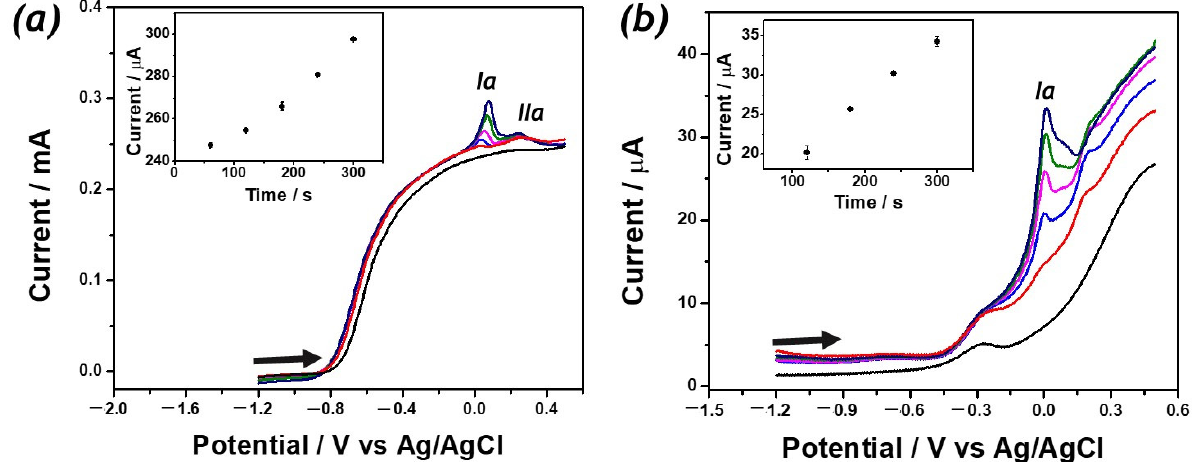
Figure 3. SWASV at different deposit times (from 60 to 300 s) in a 0.1 M LiClO 4 acetate buffer (pH 4), obtained with a ( a ) PEDOT and ( b ) PXDOT electrode in the presence of 2 ppm and 0.1 ppm of Cu 2+ , respectively. For all the experiments, E d = − 1.0 V, f = 15 Hz, Δ es = 4 mV, E SW = 50 mV as analytical parameters. The accumulation of the metal ion was carried out under stirring. Inset shows a plot of peak current vs. the deposit time.